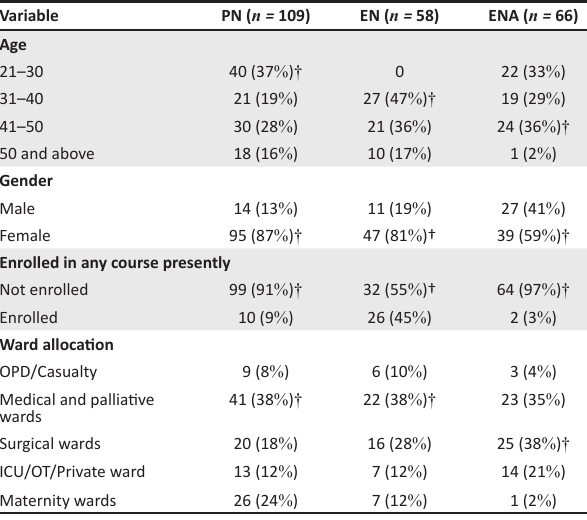
TABLE 1: Demographic characteristic. TABLE 2: Responses to different questions in the questionnaire.